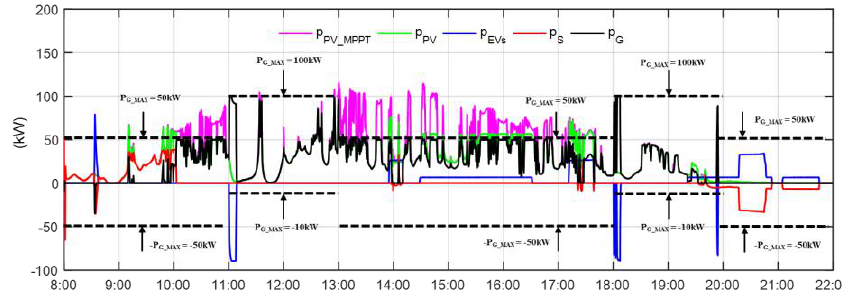
Figure 24. Power flow of DC microgrid under SPVA.